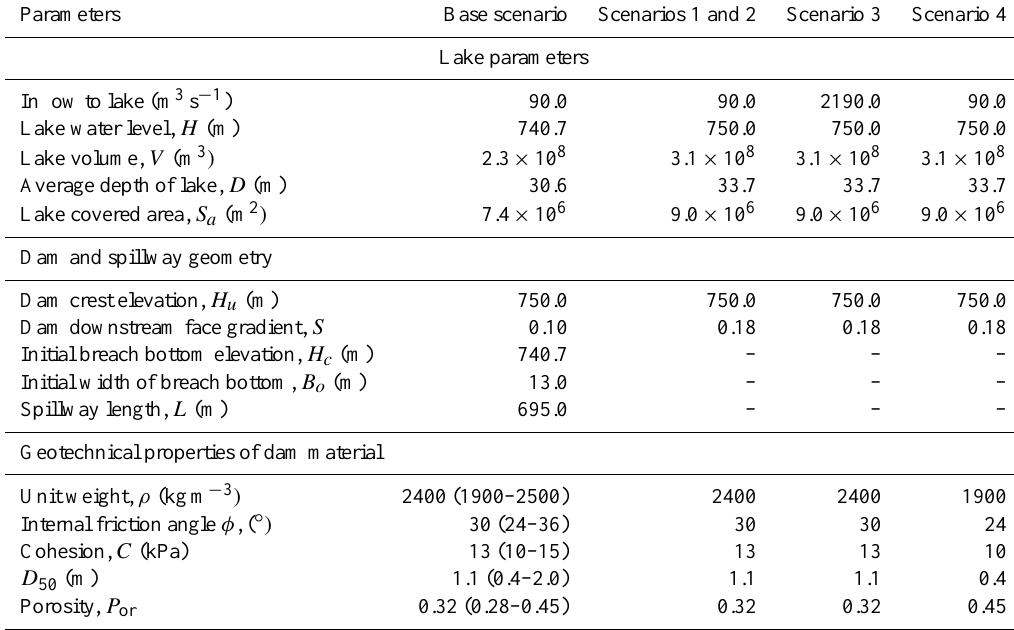
Table 2. Input parameters for the BREACH model. A range of the dam material geotechnical properties was measured using laboratory tests shown in the brackets in the base scenario column.